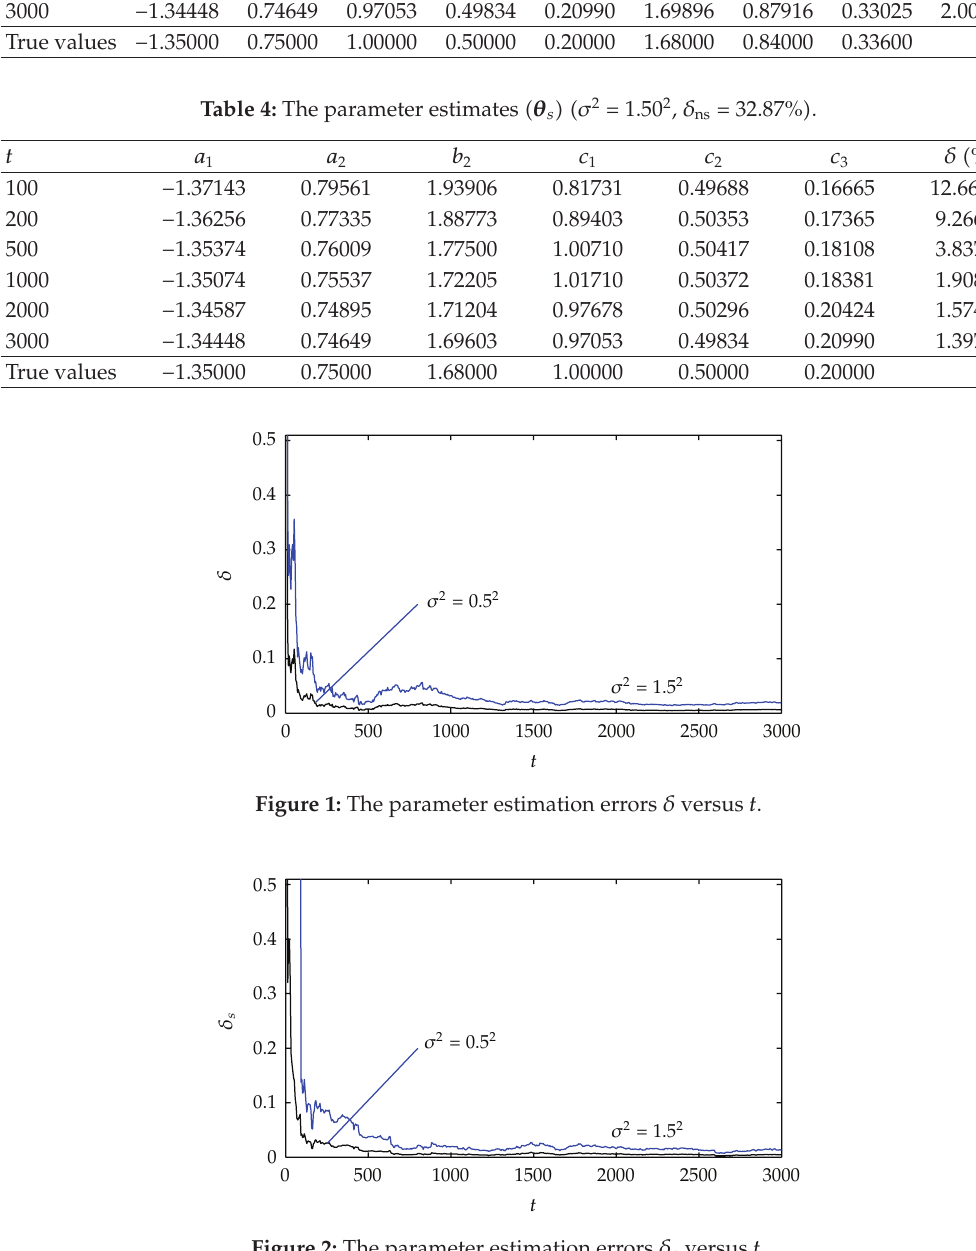
Figure 2: The parameter estimation errors δ s versus t